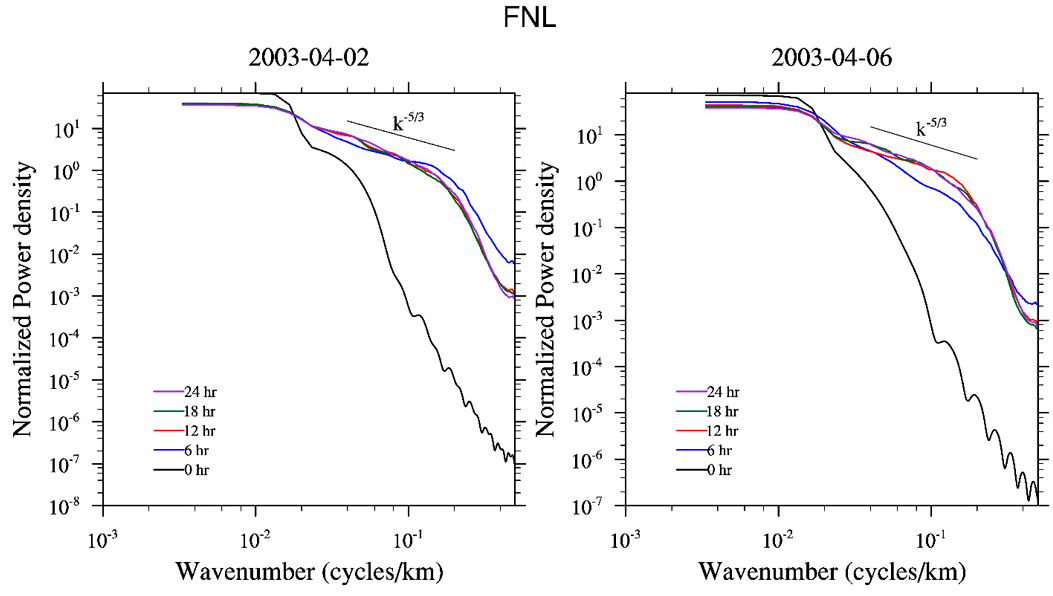
Figure 3. Kinetic energy spectra at several spin-up times when FNL initial and boundary conditions (ICs/BCs) were used.